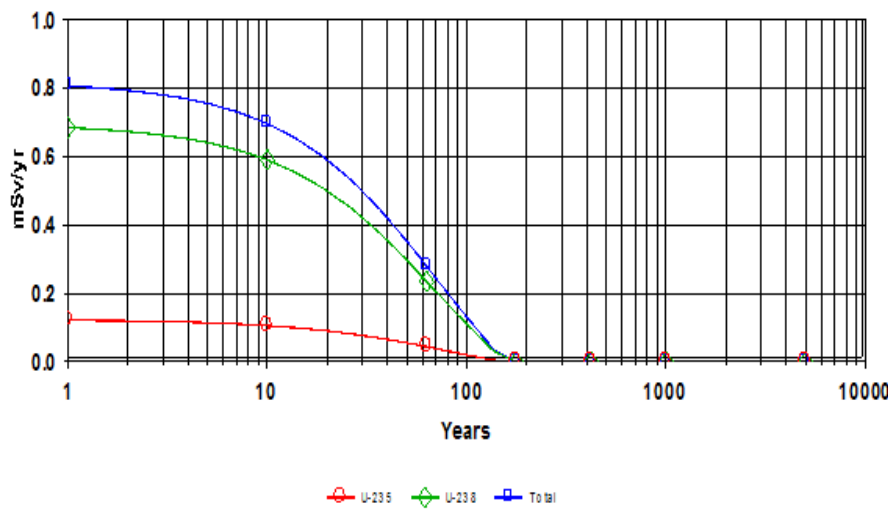
Fig.5: Annual dose over the time of area (A) for suburban resident scenario.